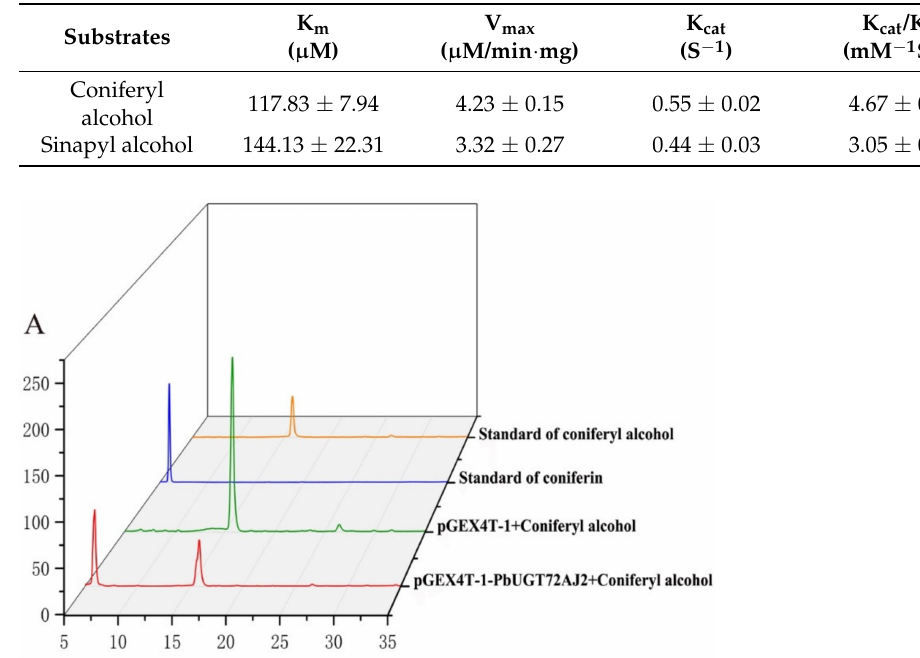
Table 1. Enzyme kinetics of PbUGT72AJ2.